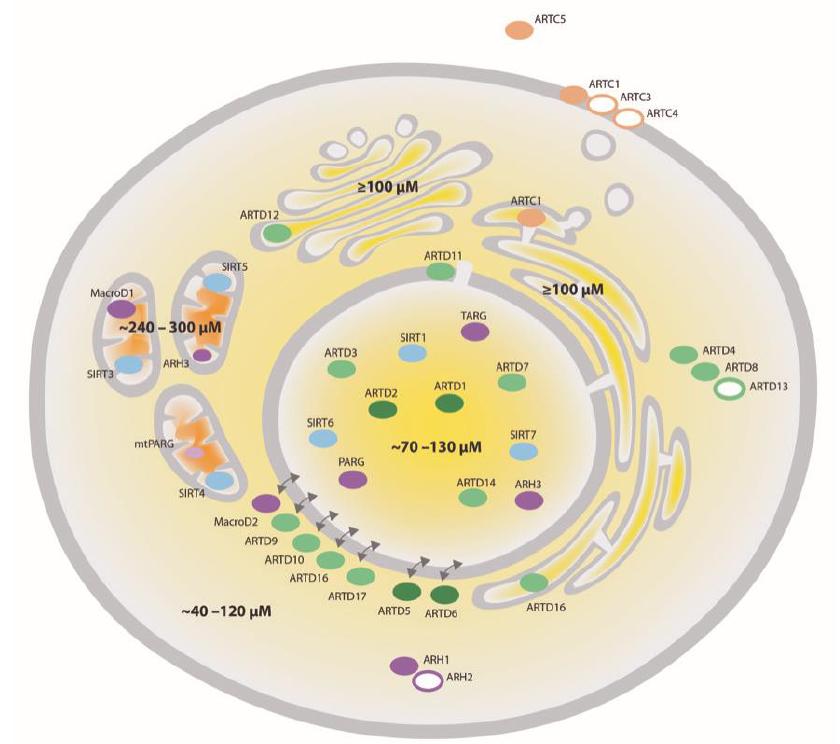
Figure 1. Compartmentalization of NAD + -converting enzymes and NAD + . NAD + -converting enzymes have been identified in different cellular compartments. ARTDs are colored in green, ARTCs—in beige, sirtuins—in blue and ADP-ribosylhydrolases (ARHs)—in purple. Filled circles symbolize active enzymes while open circles indicate enzymes whose activity has not been confirmed so far. The intensity of the color shows the expected intensity of the enzymatic activity. The concentration of NAD + (depicted in different yellow to orange shades) is high in mitochondria ( ∼ 300 µ M), intermediate in the nucleus and cytosol ( ∼ 100 µ M) and low (<1 µ M) in the extracellular space and can vary considerably depending on the cell type, metabolic condition, stress and redox status. Poly-ADP-ribose glycohydrolase (PARG); Terminal ADP-ribose protein glycohydrolase (TARG).